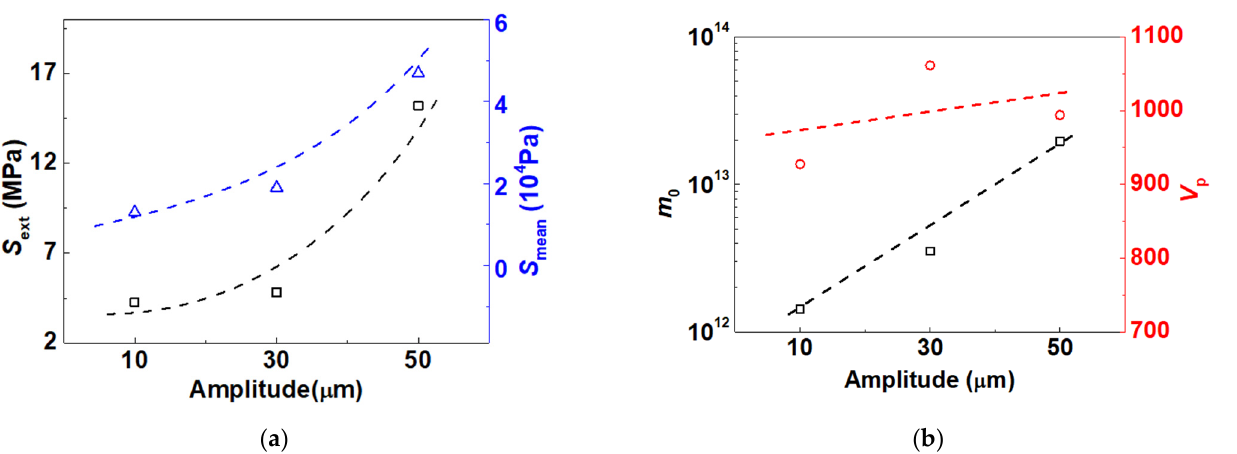
Figure 15. Changes of ( a ) time and ( b ) frequency domain characteristic parameters of axial compres- sive stress on the pressboard under different vibration amplitudes.